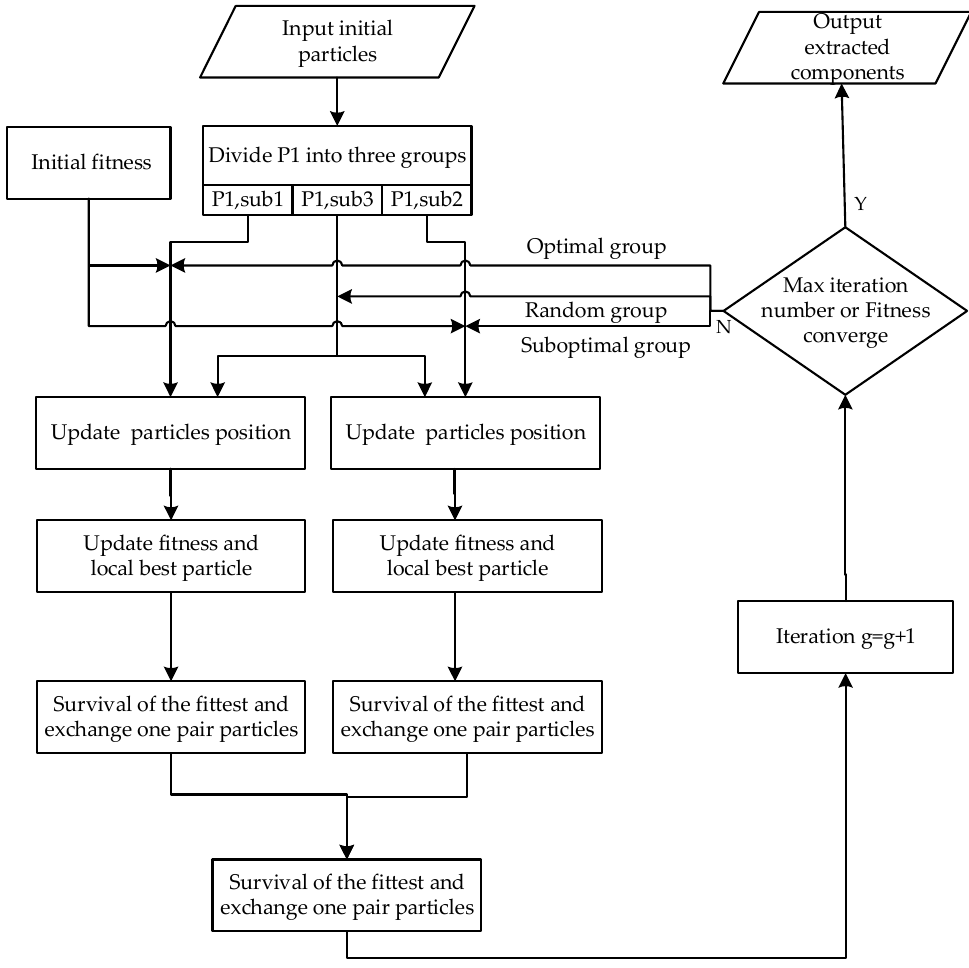
Figure 2. The procedure of the co-evolutionary PSO algorithm.